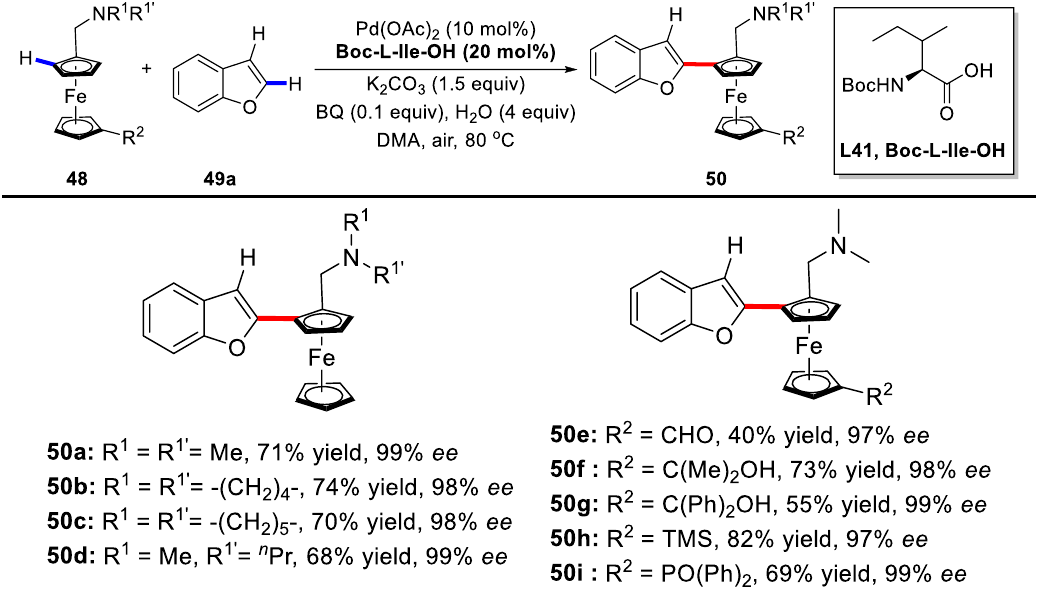
Scheme 38. Enantioselective cross-coupling reactions of benzofurans [88].